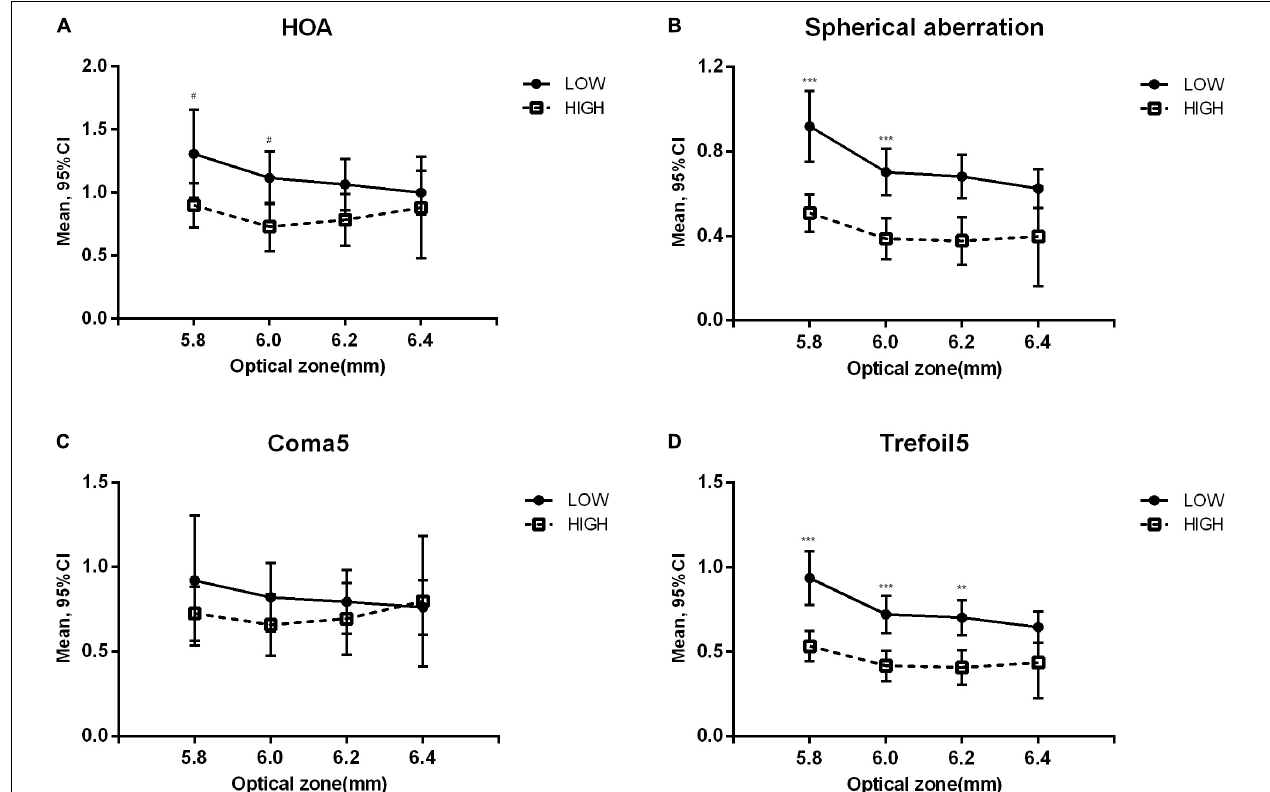
FIGURE 2 | Variation of higher-order aberrations at the last follow-up in low and high optical zone groups. Low: optical zone less than or equal to the value on the corresponding horizontal axis. High: optical zone higher than the value on the corresponding horizontal axis. Compared between optical zone groups: *** p < 0.001, ** p < 0.01, # p < 0.05. (A) Total higher-order aberration (HOA). (B) Spherical aberration. (C) 3rd and 5th order coma (Coma5). (D) 3rd and 5th order trefoil